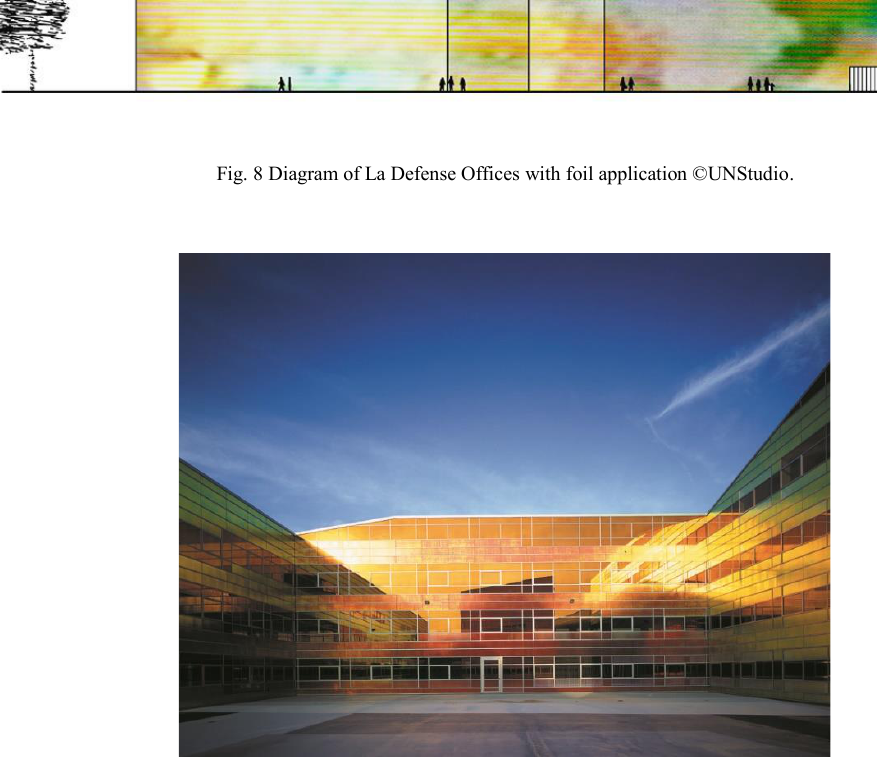
Fig 9. La Defense Offices ©Christian